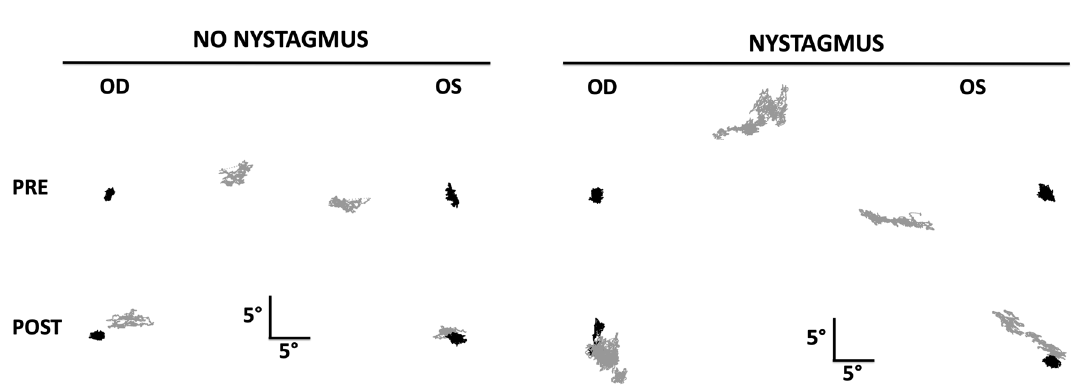
Figure 3. Representative fixation plots pre- and post- strabismus repair, from a subject with no nystagmus and a subject with nystagmus. Gray = non-viewing eye, Black = viewing